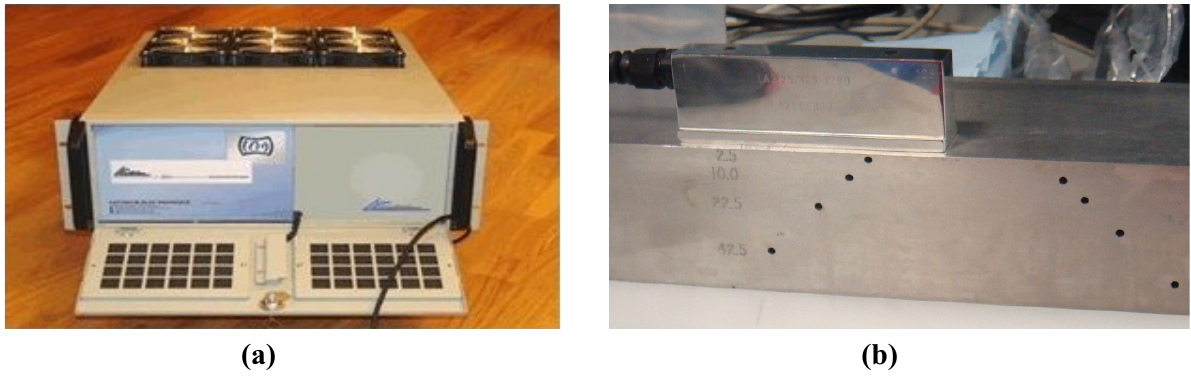
Figure 9. Experimental apparatus. (a) OPEN ultrasound phased array control system (LeCouer, France), (b) 5 MHz, 128-element linear transducer array (Vermon, France) and test sample of solid steel block with multiple side-drilled holes. Transducer array is in contact with sample upper surface with gel coupling.